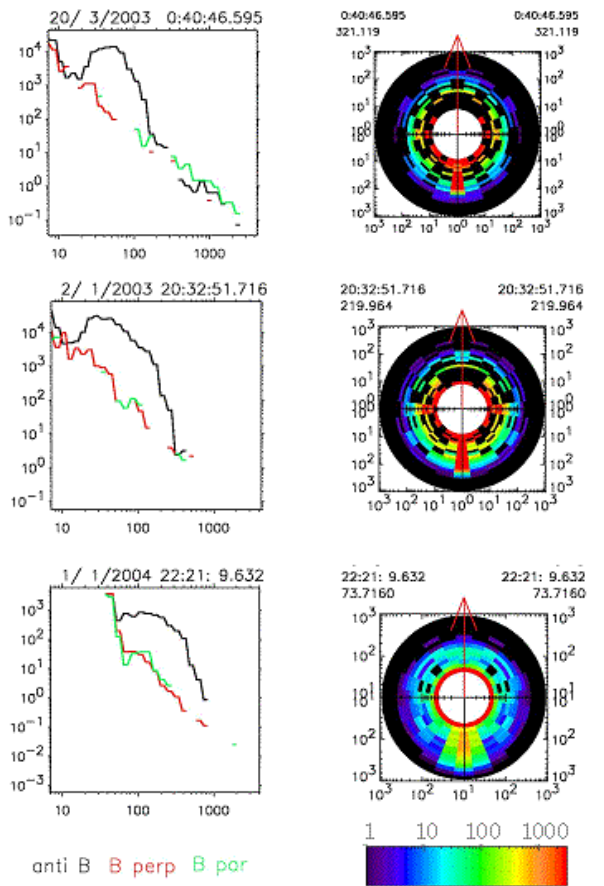
Fig. 4. Left-hand side: electron distribution functions f × 10 18 (s 3 /m 6 ) for 3 beams as functions of the energy, in 3 directions: upgoing along the magnetic field B (black curve labelled antiB), downgoing (green curve labelled Bpar) and perpendicular to B (red curve labelled Bperp). Right-hand side: the corresponding pitch- angle distribution functions f × 10 18 (s 3 /m 6 ) in all directions. The red arrow represents B